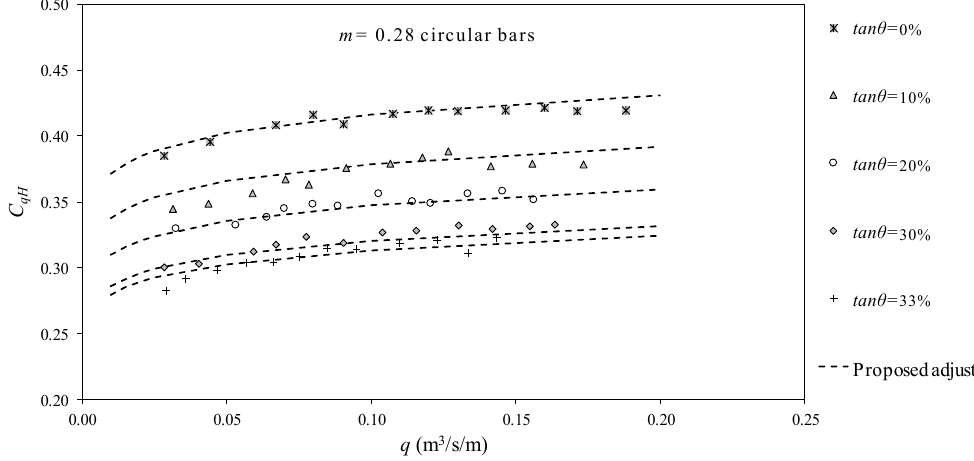
Figure 22. Mean discharge coefficient C qH as a function of the incoming flow q , for circular bars with void ratio m = 0.28.